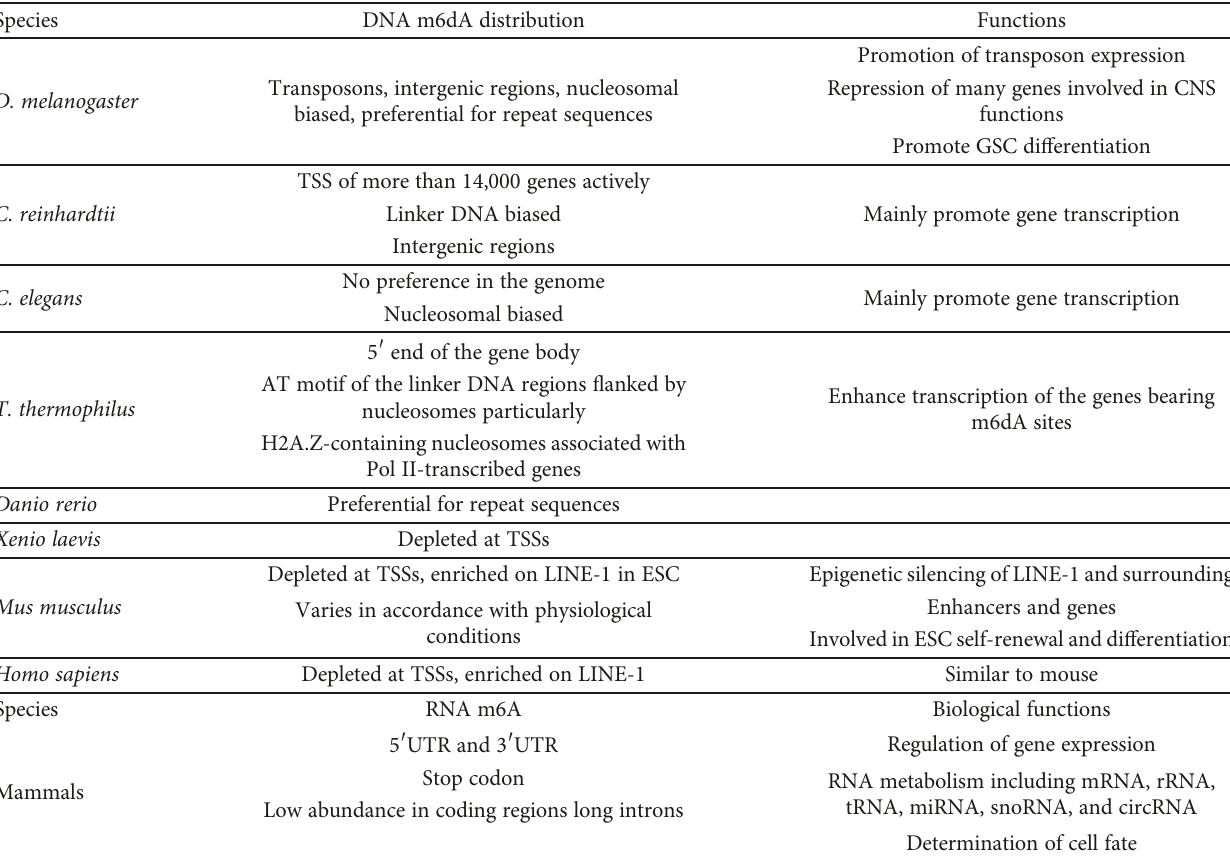
Table 2: Distribution of the methylated adenosine in DNA and